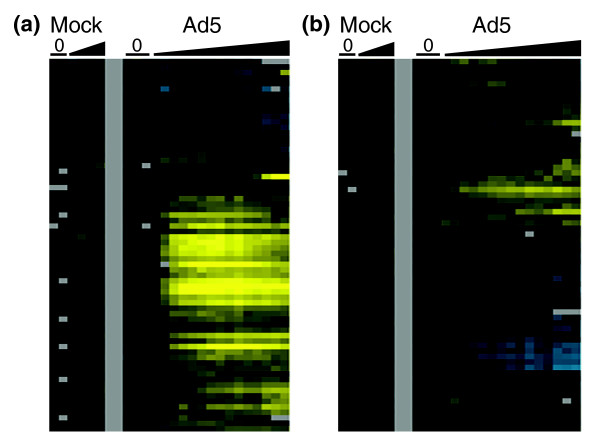
The expression of E2F target genes in Ad5 infected HFFs. (a) The 67 genes bound by E2F2 or E2F4 identified by Ren and coworkers [86] and (b) 67 randomly chosen genes were isolated from the complete dataset while excluding genes with responses to mock treatment. The genes in both panels were hierarchically clustered for easier viewing. Ramps above panels indicate increases in time after infection. Ad5, adenovirus type 5; HFF, human foreskin fibroblast.